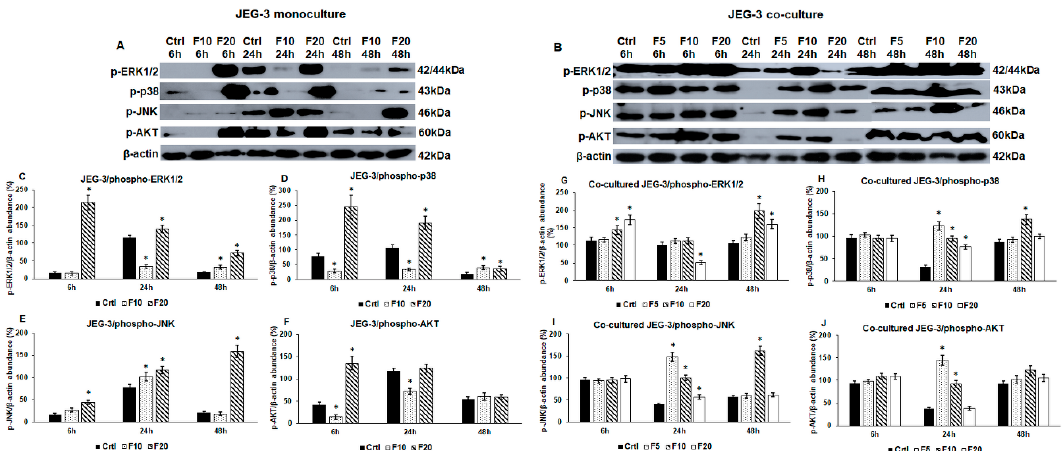
Figure 2. Western blot analyses of signalling pathways regulated by fractalkine in mono- ( A ) and co-cultures ( B ) JEG-3 cells. Cells were collected and pelleted after fractalkine treatments then cells were lysed and their protein contents were measured. The same amount of protein (10 µ g) from each sample was separated by SDS-PAGE using 12% polyacrylamide gel, transferred by electroblotting to nitrocellulose membranes. The membranes were probed with anti-phospho-ERK1 / 2, anti-phospho-p38, anti-phospho-JNK and anti-phospho-AKT according to the manufacturer’s instruction. The experiments were repeated three times. β -actin was used as loading control. ( C – F ) Optical density analyses of the examined proteins in JEG-3 monocultures. ( G – J ) Optical density analyses of the examined proteins in co-cultured JEG-3 cells. The analyses were carried out using ImageJ software; the optical densities of the examined proteins were expressed as percentage of target protein / β -actin abundance. The bars represent mean values and error bars represent standard deviation (SD) for three independent experiments ( n = 3). The * mark p < 0.05 compared to the appropriate controls (6 h, 24 h and 48 h). Abbreviations of fractalkine treatments: 5 ng / mL-F5; 10 ng / mL-F10; 20 ng / mL-F20.